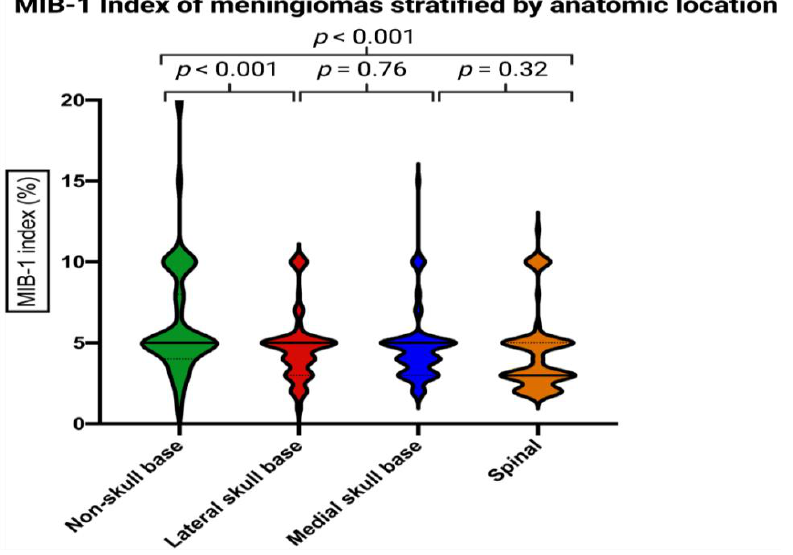
Figure 2. Violin plots displaying the MIB-1 indices in descending order among the anatomic locations. Violin plots shows mean and distribution of MIB-1 index. The thick horizontal black lines are the median values. p -values of the Student´s t -test are reported. Table 3. Comparison of mean MIB-1 labeling indices among anatomic locations of meningioma.